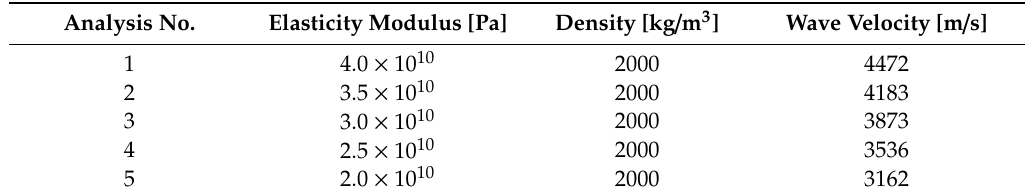
Table 3. Parameters for analysis of grout sti ff ness influence.